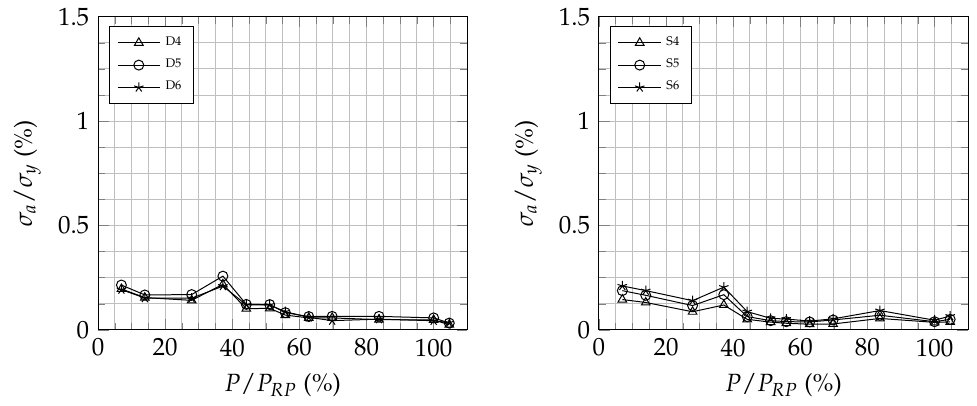
Figure 27. Dynamic stresses at strain gauge positions close to the runner shroud for PS ( left ) and SS ( right